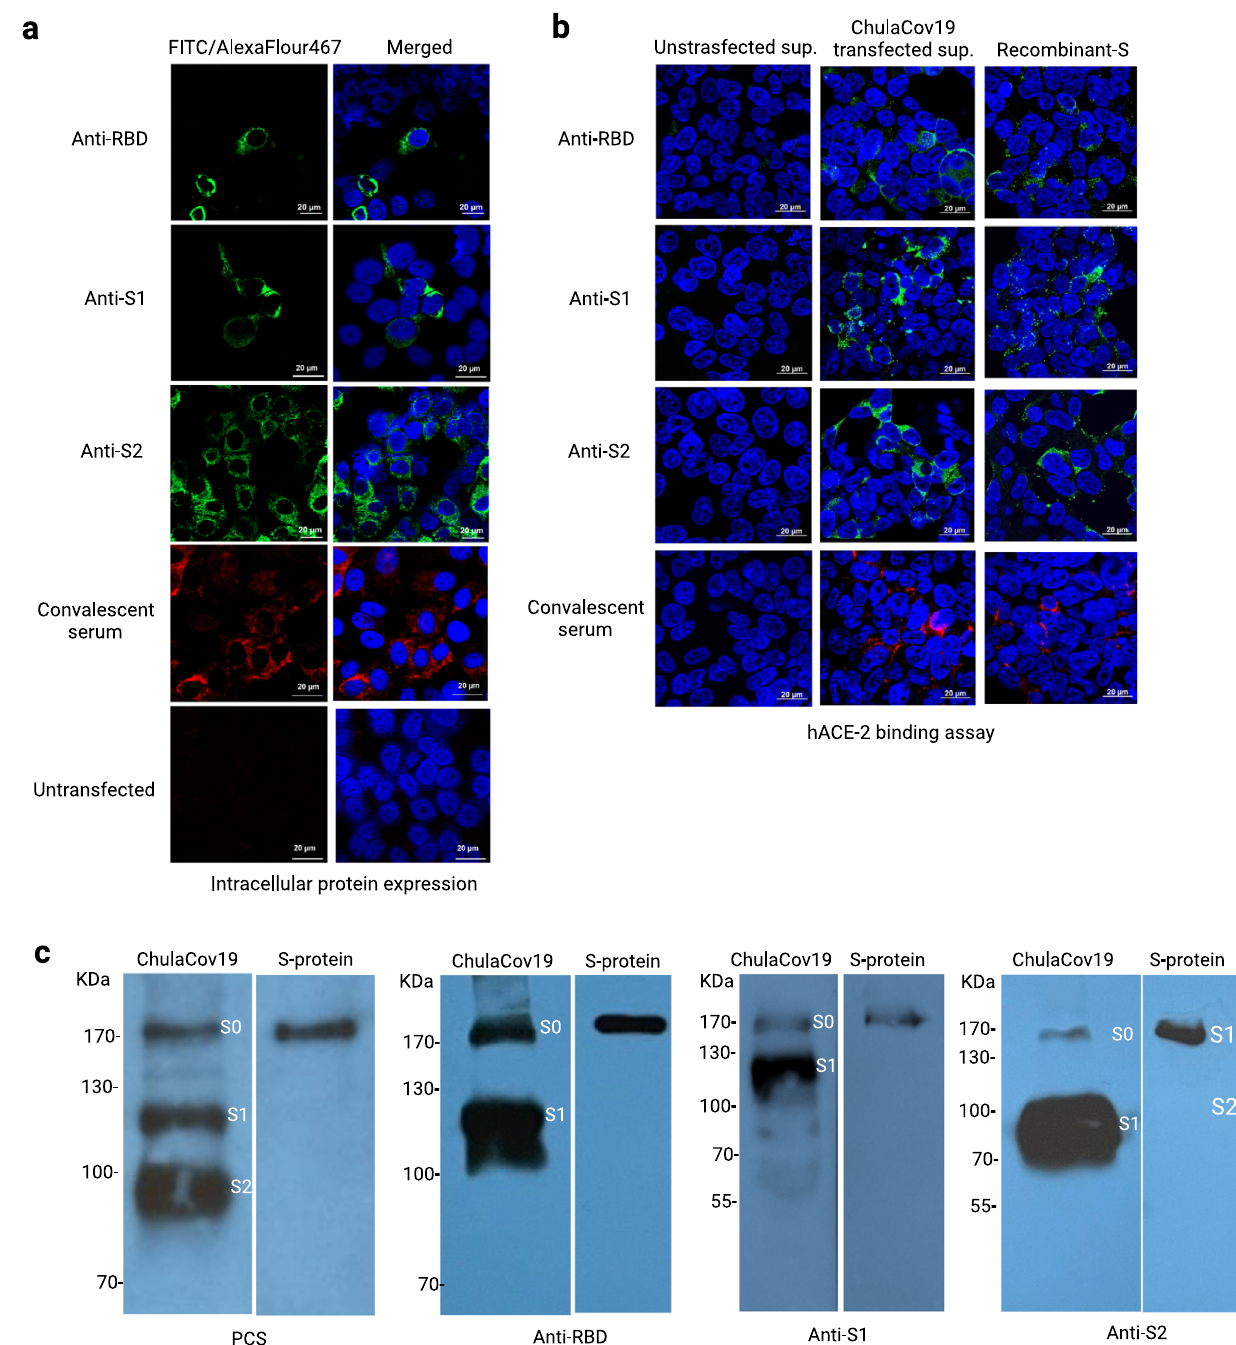
Fig. 2 | Proteinexpressionanalysis at 24h aftermRNA transfectionin VEROE6 cells. a Intracellular S protein expression examined by immuno fl uorescent assay employing anti-RBD, -S1, -S2 or PCS as primary antibody, the nuclei were counter stained with DAPI (blue). FITC-tagged 2 nd Abs (green) were used for detection of RBD, S1, and S2 while AlexaFluor647-tagged 2 nd Ab (red) was used following PCS staining. b hACE-2 binding assay (merged): culture supernatant collected from ChulaCov19 transfected cells incubated with HEK293T- hACE-2 cells. S protein on